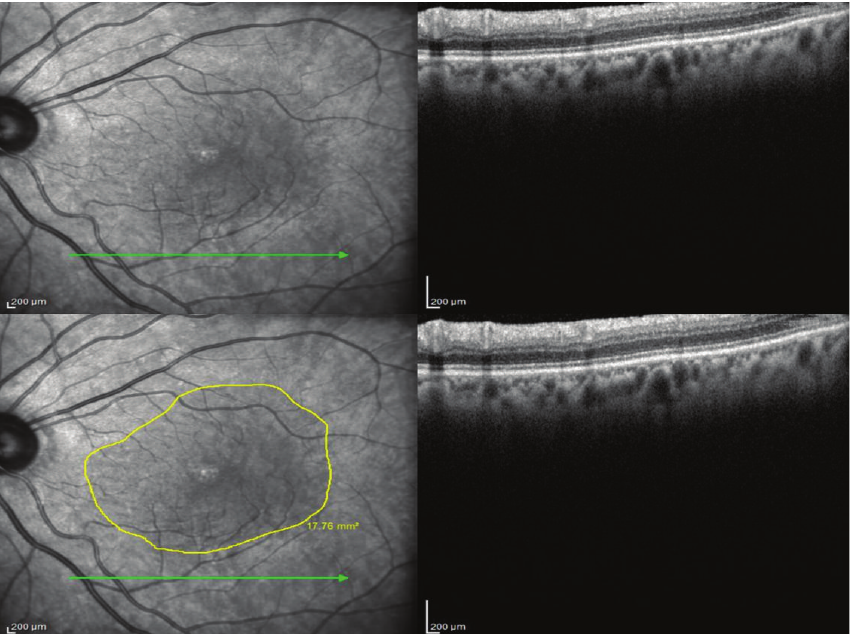
Figure 1: The borders of the peeled ILM area were marked, and the area was calculated using spectral domain optical coherence